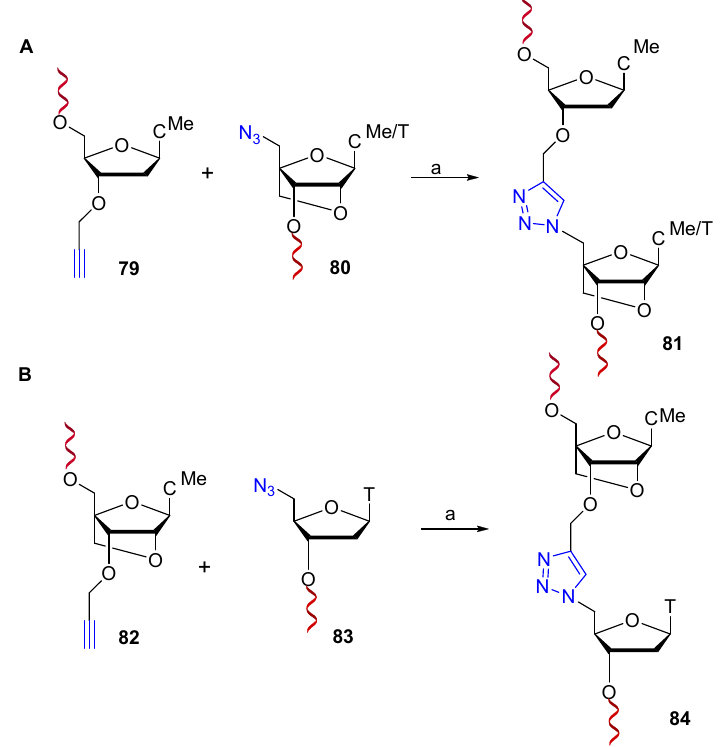
Scheme 20 . ( A ): Synthesis of triazole 3 ′ -LNA: ( B ): Synthesis of triazole 5 ′ -LNA. Reaction condi-